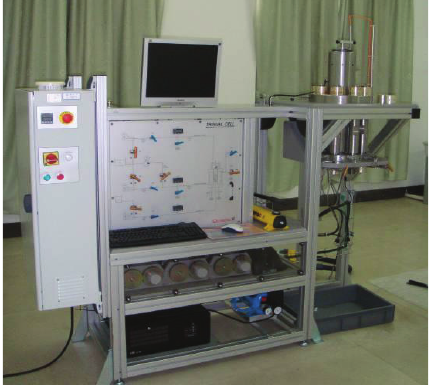
Figure 4: Triaxial coupling test instrument.